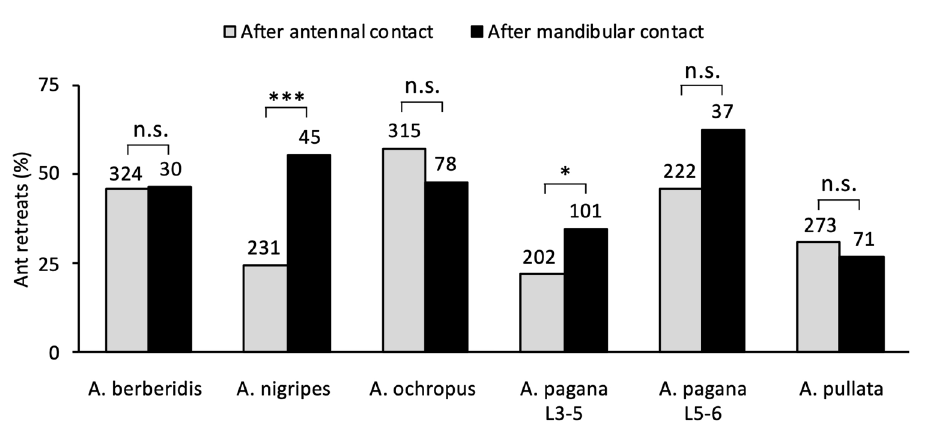
Figure 3. Ant retreating from a sawfly larva in short-term interactions. The histogram represents percentages of ant retreats after contacting a larva with its antennae or mandibles. Sawfly species/instars are given on the X -axis (Table 1). Above each histogram bar is given the total number of antennal or mandibular contacts. Statistical results were obtained by Fisher exact probability tests, two-tailed, comparing the number of retreats after an ant’s antennal vs. mandibular contact: P > 0.05 (n.s.), P < 0.05 (*), P < 0.001